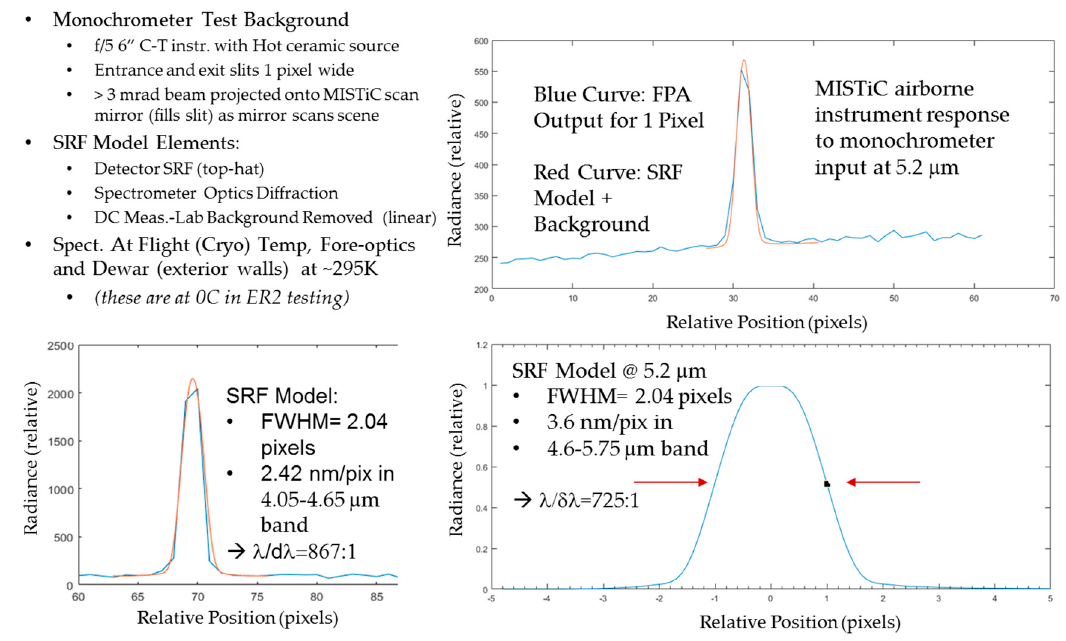
Figure A3. Monochrometer testing of the MISTiC spectral response function shows spectral resolving power meeting MISTiC requirements at the operating temperatures planned for space